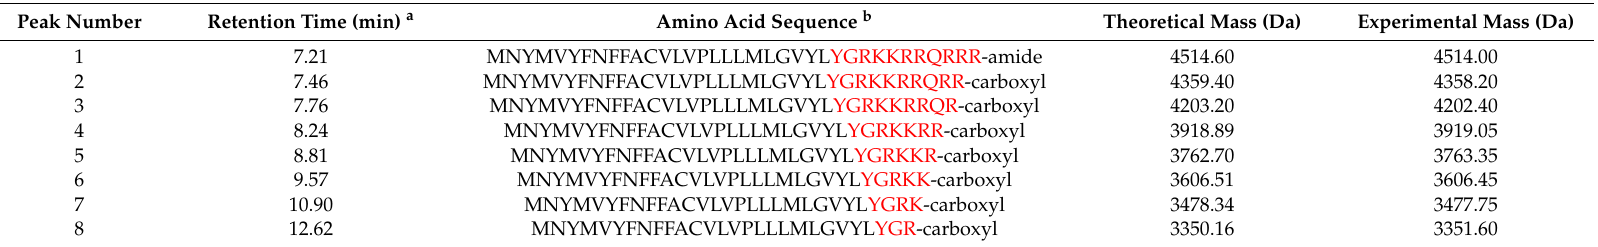
Table 2. Primary structures and physicochemical properties of linear peptide 1 and its tryptic fragments (Figure